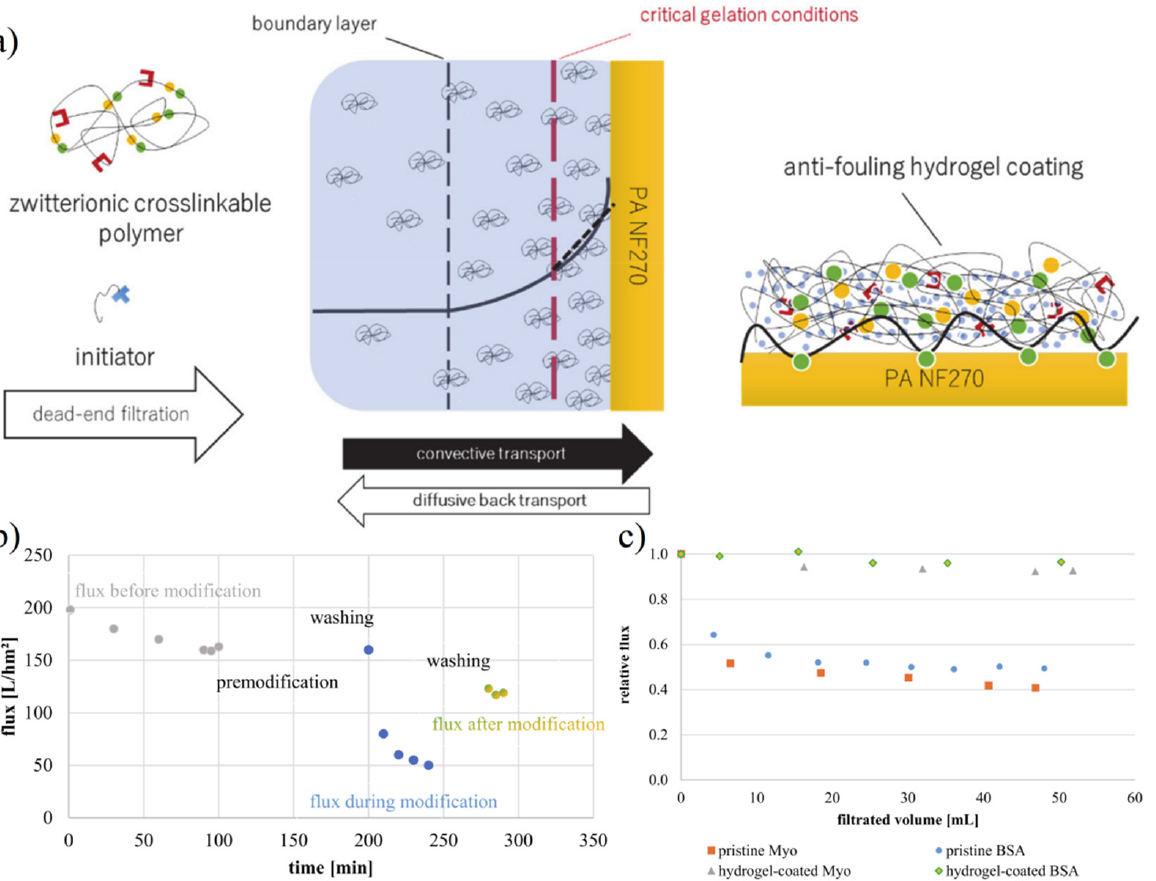
Figure 12. Antifouling zwitterionic hydrogel on the membrane to resist flux loss caused by nonspecific protein adsorption. ( a ) Schematic illustration of zwitterionic hydrogel coating on nanofiltration membrane via concentration polarization. ( b ) A dense hydrogel network caused membrane flux loss. ( c ) The relative flux was retained in the protein solution. Reproduced with permission from [27]. Copyright 2021 MDPI.